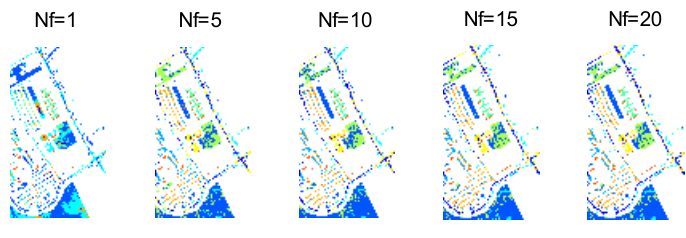
Figure 5. The obtained class maps with (cid:13)